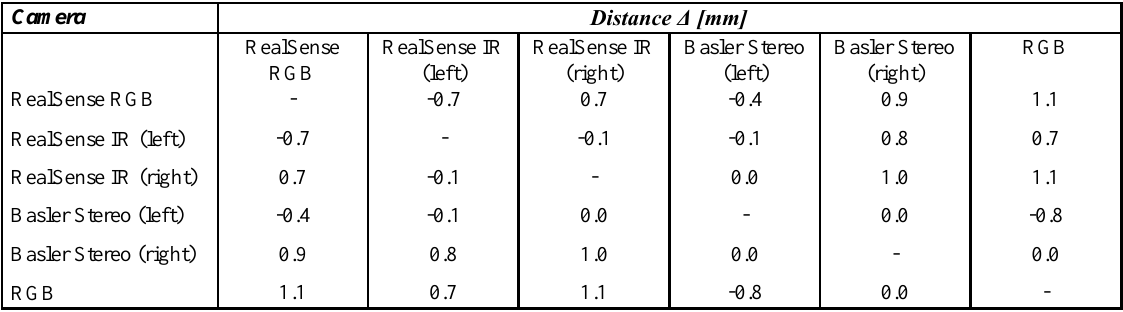
Table 7: Matrix of distances between sensor poses estimated in two multi-camera calibration runs. RGB camera calibration: 0.014° for the rotation matrix and 1.17 mm for the translation matrix.